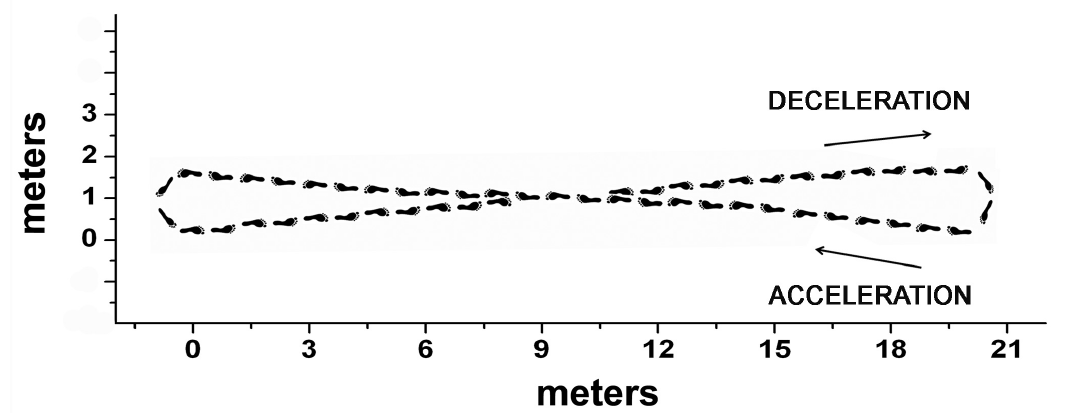
Figure 1. Illustration of the eight-shaped path used in our